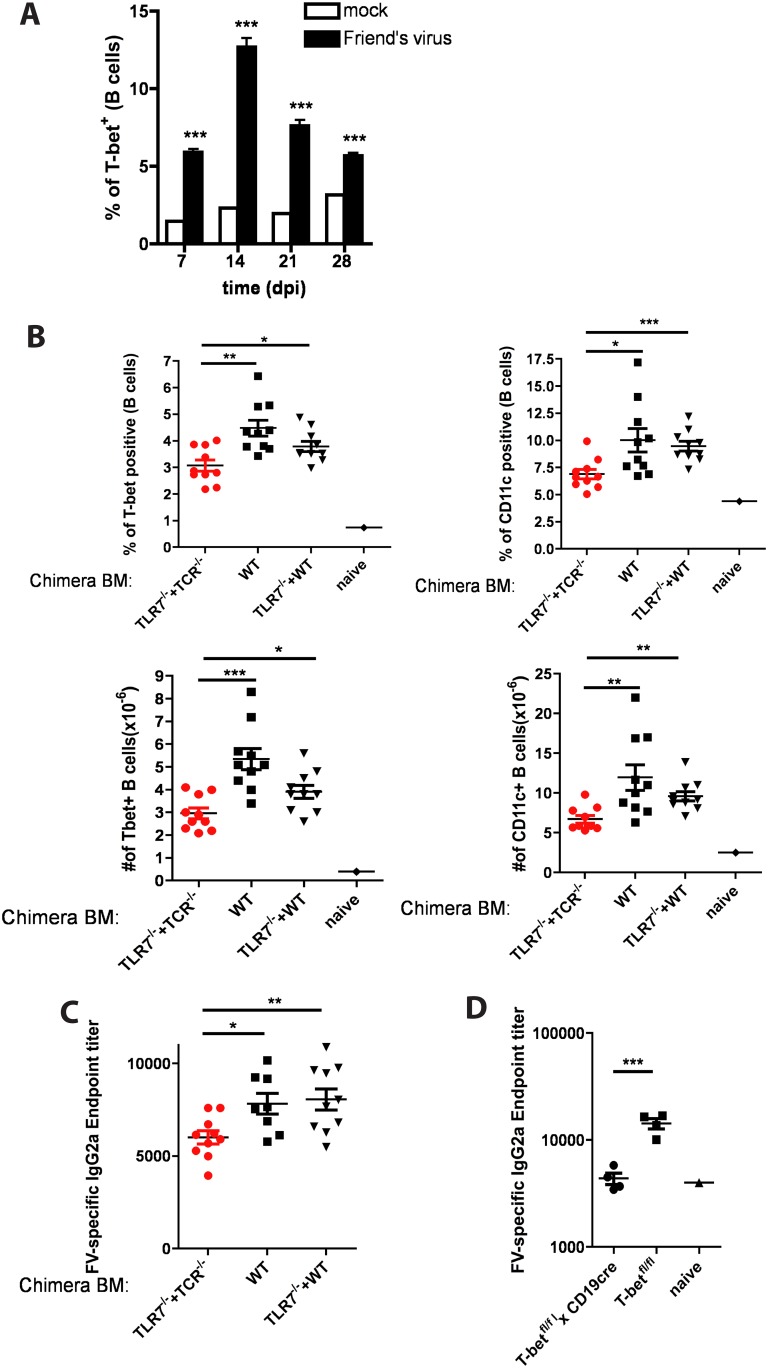
TLR7 expression in T cells is required for the accumulation of T-bet+ B cells and effective production of anti-viral IgG2a during Friend virus infection.(A) C57BL/6 mice (n = 5 per time point) were infected with 104 SFFU of Friend virus (FV). Spleens were harvested on day 7, 14, 21 or 28 post infection. The presence of T-bet+ cells among B cells was assessed by FACS. Bar graphs represent percentage of T-bet+ cells among B cells. (B, C) Bone marrow chimera were constructed as described in Methods, such as in (TLR7-/- + TCR-/-) mice only T cells completely lack TLR7 expression and the rest of the hematopoetic cells were 80% WT and 20% TLR7-/-. Bone marrow chimeras were infected with FV (as in (A)) and spleens and serum were harvested on 14 dpi percentage and numbers of T-bet+ or CD11c+ B cells is shown (B). Serum collected at 14dpi was assessed for the presence of anti-FV IgG2a by ELSIA (C). (D) T-betfl/fl, and T-betfl/flxCD19CRE mice (n = 4 mice per group) were infected with FV as in (A). Serum was collected at 15 dpi and the presence of anti-FV IgG2a was assessed by ELISA. Bars represent the means +/- SEM. Data are representative of three or more independent experiments.